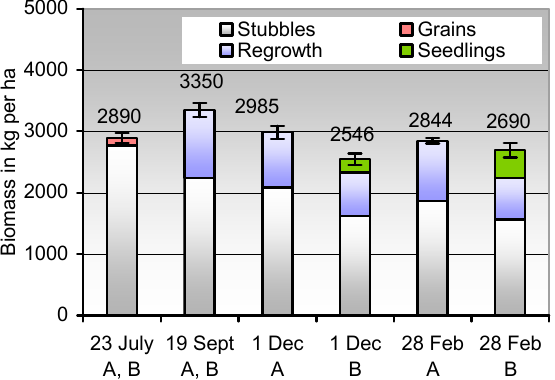
Figure 5. Persistence of the biomass from harvest to postwinter in the composition of decaying wheat stubbles, spilt grains, the biomass regrowing from spilt grains, and the seedlings of the subsequent crop. A, Crop rotation wheat-maize; B, rotation wheat-wheat. The upper columns do not refer to the zero axis. Error bars, ± SD for the total biomass values heading the columns.